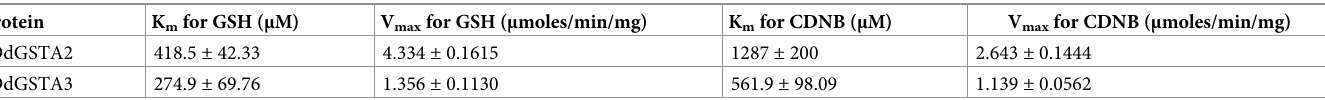
Table 4. Calculated K m and V max values for rDdGSTA2 and rDdGSTA3 Isozymes for GSH and CDNB. Protein K m for GSH ( μ